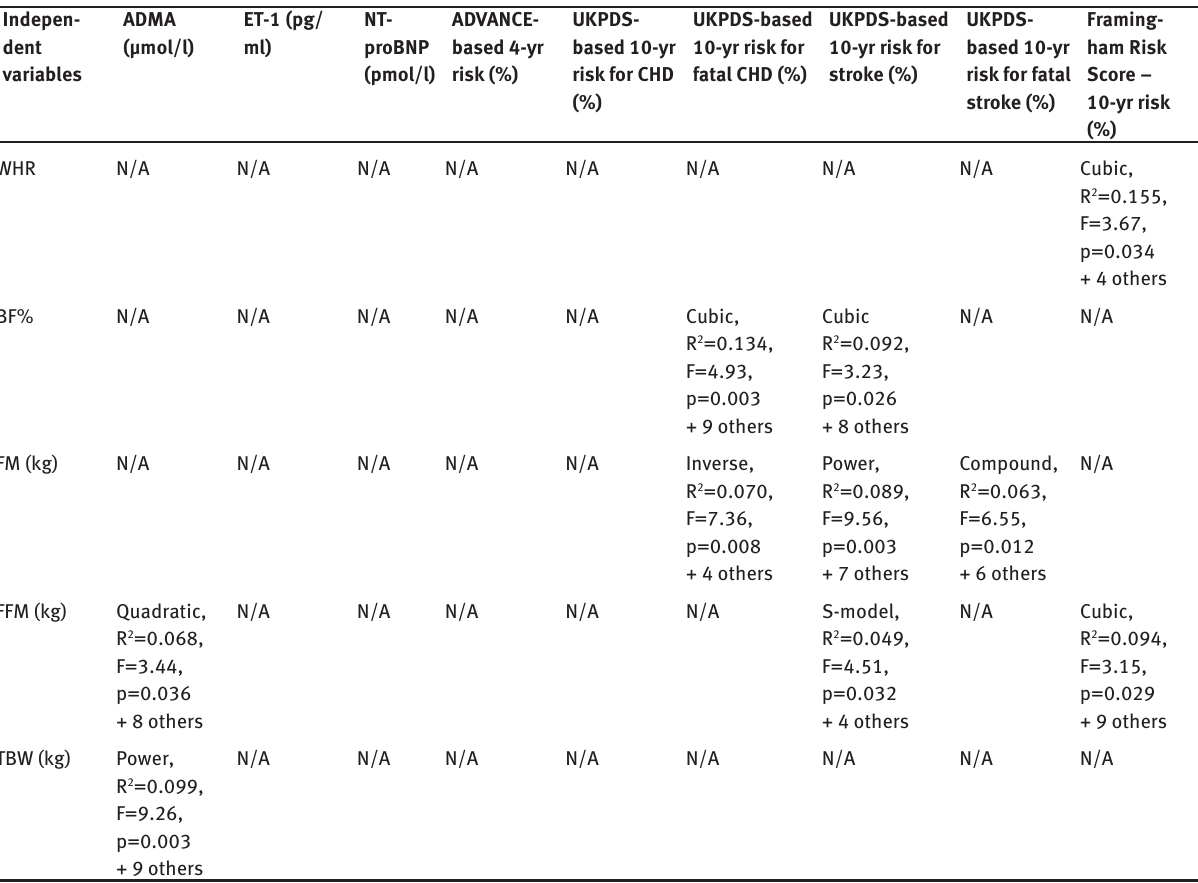
Table 2 continued: The correlation and coefficients and regression models linking the anthropometric and body composition indices (inde- pendent variables) with the biochemical/endothelial markers and the calculated cardiovascular risks (dependent variables) are shown. The significant Spearman’s Rho Rank coefficients are